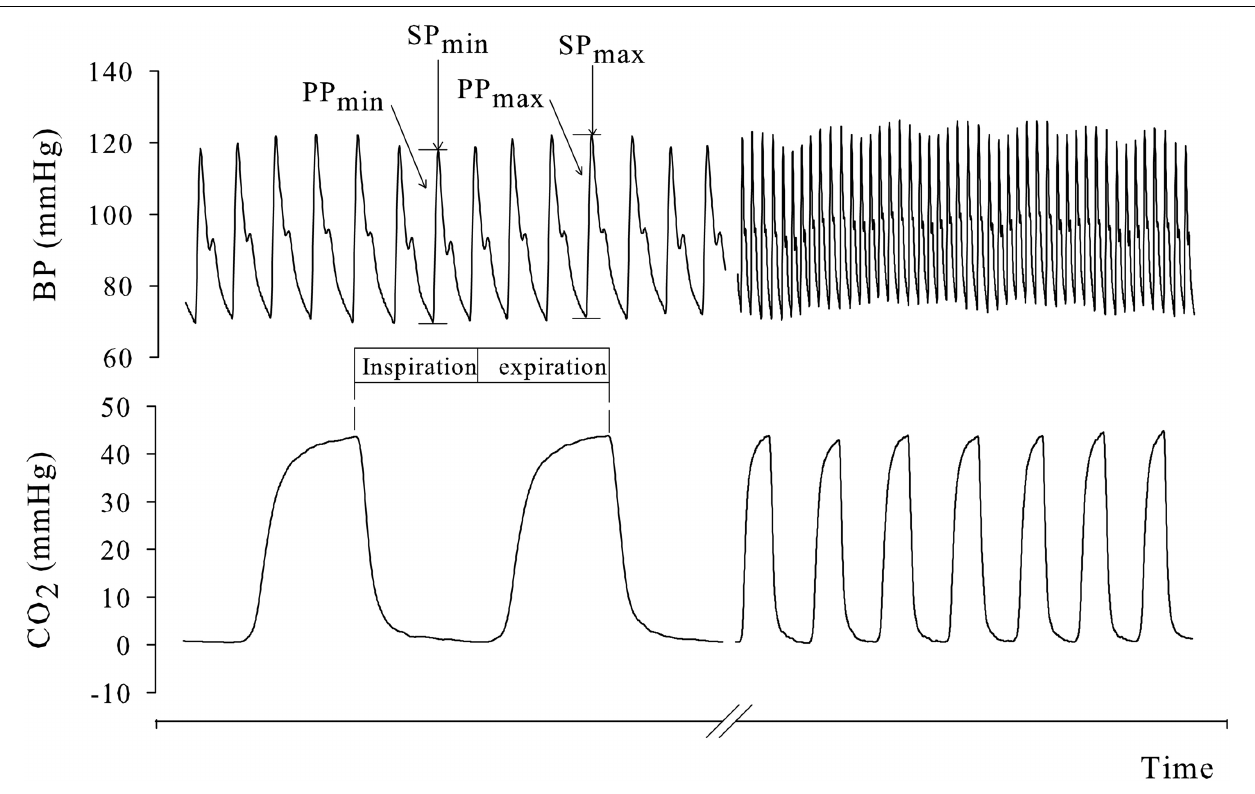
FIGURE 1 | Variation in pulse and systolic pressure (PP and SP, respectively), induced by respiration. PPV and SPV were first calculated (Equation 1) per breath and then averaged over five consecutive breaths.